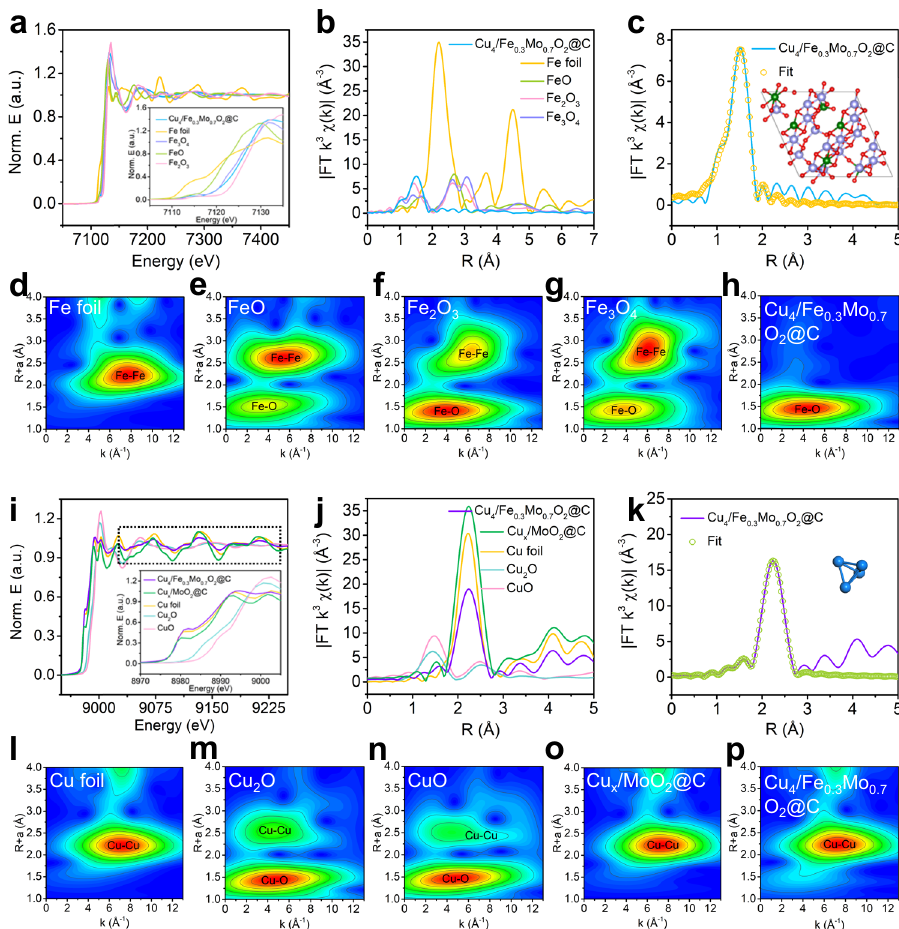
Fig. 3 XANES characterization of Cu 4 /Fe 0.3 Mo 0.7 O 2 @C. a XANES spectra at the Fe K-edge of Fe foil, FeO, Fe 2 O 3 , Fe 3 O 4 , and Cu 4 /Fe 0.3 Mo 0.7 O 2 @C (Fe). b Fourier transform (FT) at the Fe K-edge of Fe foil, FeO, Fe 2 O 3 , Fe 3 O 4 , and Cu 4 /Fe 0.3 Mo 0.7 O 2 @C (Fe), and c corresponding EXAFS fi tting curves of Cu 4 / Fe 0.3 Mo 0.7 O 2 @C (Fe) in R space. Inset: model of Fe 0.3 Mo 0.7 O 2 ; Fe (green), Mo (purple), and O (red). WT for the k 3 -weighted EXAFS signals of d Fe foil, e FeO, f Fe 2 O 3 , g Fe 3 O 4 , and h Cu 4 /Fe 0.3 Mo 0.7 O 2 @C (Fe). i XANES spectra at the Cu K-edge of Cu foil, Cu 2 O, CuO, Cu x /MoO 2 @C, and Cu 4 / Fe 0.3 Mo 0.7 O 2 @C (Cu). j Fourier transform (FT) at the Cu K-edge of Cu foil, Cu 2 O, CuO, Cu x /MoO 2 @C, and Cu 4 /Fe 0.3 Mo 0.7 O 2 @C (Cu), and k corresponding EXAFS fi tting curves of